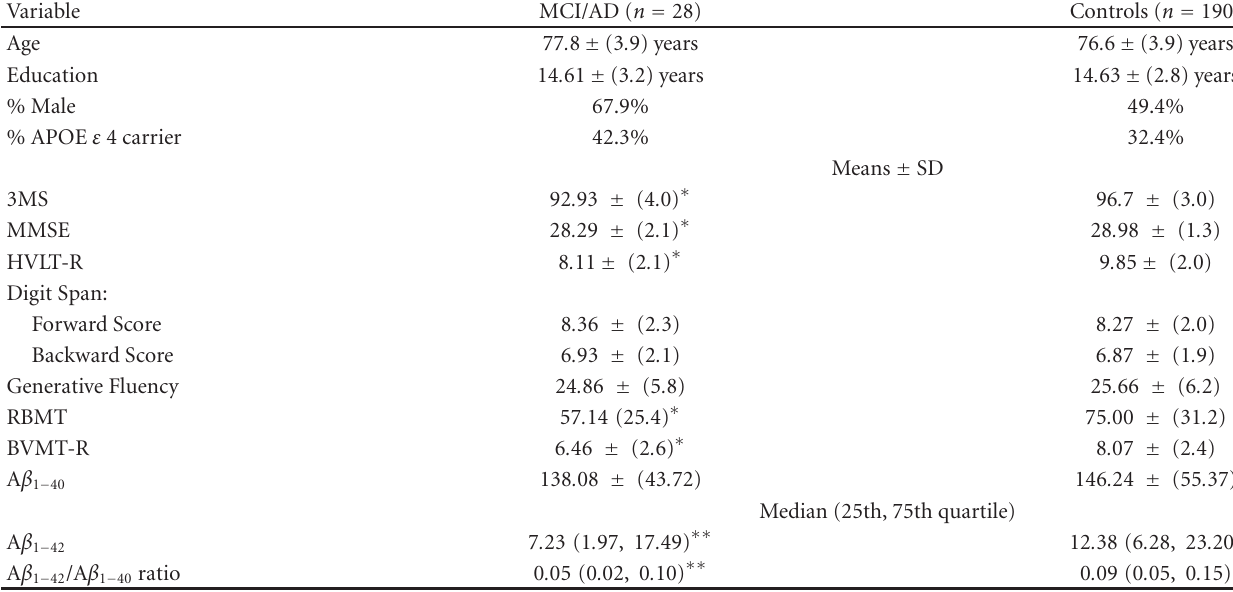
Table 1: Variable comparisons between